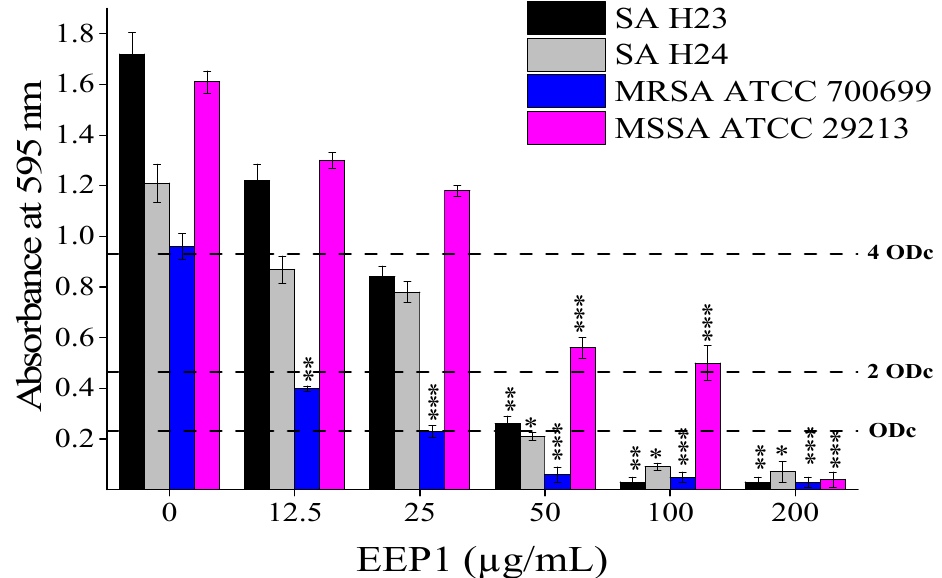
Figure 2. The effect of EEP1 (12.5–200 µg/mL) on the prevention of biofilm formation of S. aureus SA H23 and SA H24 clinical isolates, and S. aureus ATCC 29213 (MSSA) and S.aureus ATCC 700699 (MRSA) strains after 24 h incubation at 37 °C. (ODc) the cut-off value of the optical density. (OD ≤ ODc) means no biofilm, (ODc < OD ≤ 2 ODc) means weak biofilm, (2 ODc < OD ≤ 4 ODc) means moderate biofilm, (4 ODc < OD) means strong biofilm. Asterisks indicate statistically significant differences between each treatment of EEP1 and in absence of EEP1 (* p <0.05, * p < 0.01, *** p < 0.001).